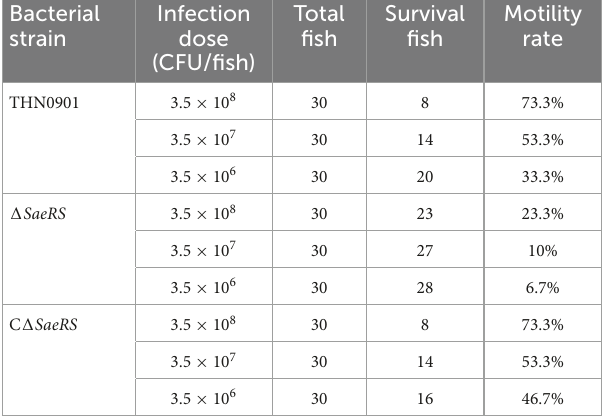
TABLE 2 Cumulative survival of tilapia